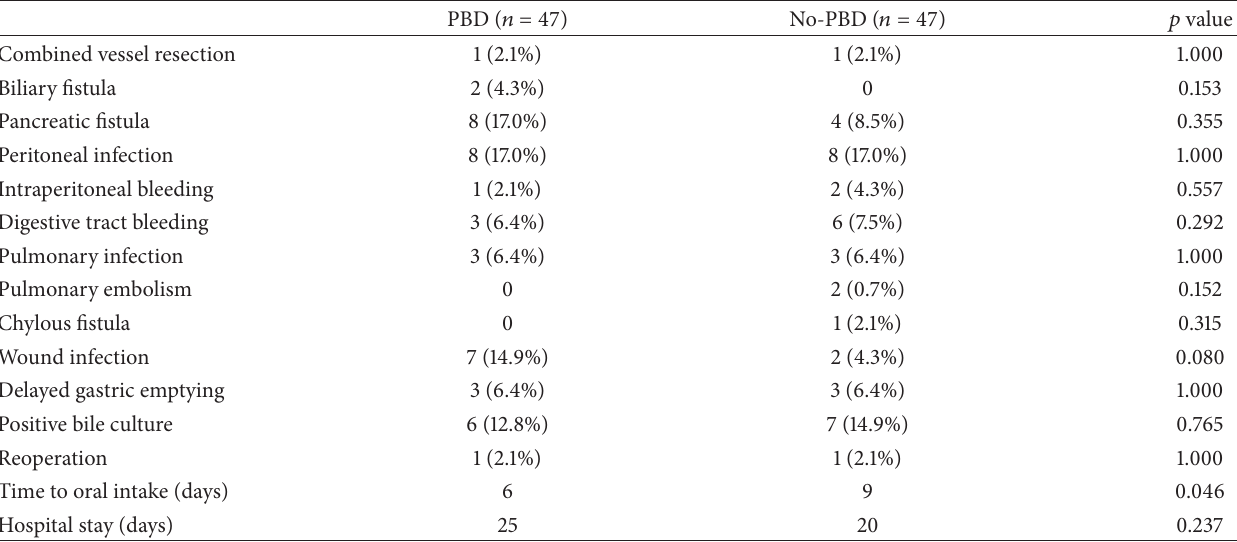
Table 5: Intraoperative characteristics and postoperative complications in matched